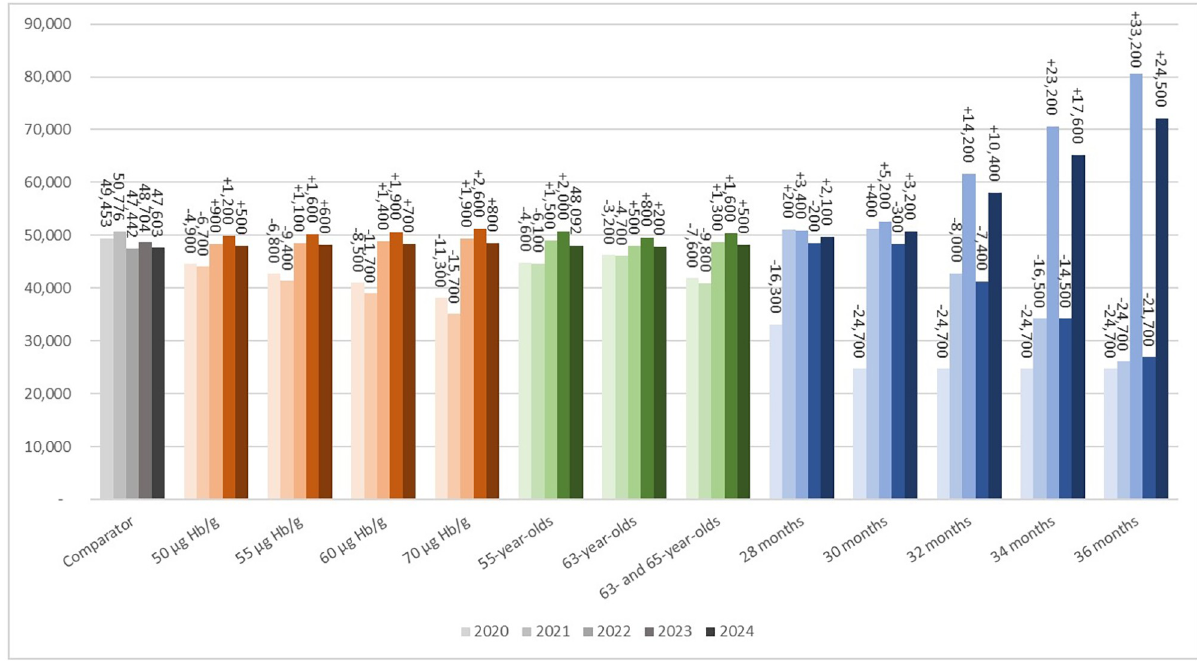
Fig 1. Colonoscopy demand for the comparator strategy, increasing the cut-off value, skipping screening ages and extending the screening interval for 2020, 2021, 2022, 2023 and 2024. Note that in the comparator scenario, we simulated the Dutch CRC screening program including the 3-month disruption from April 2020 and after the disruption individuals’ missed invitations were caught up in the next 3 months. Abbreviations: CRC, colorectal cancer; μ g Hb/g, microgram Haemoglobin per gram.